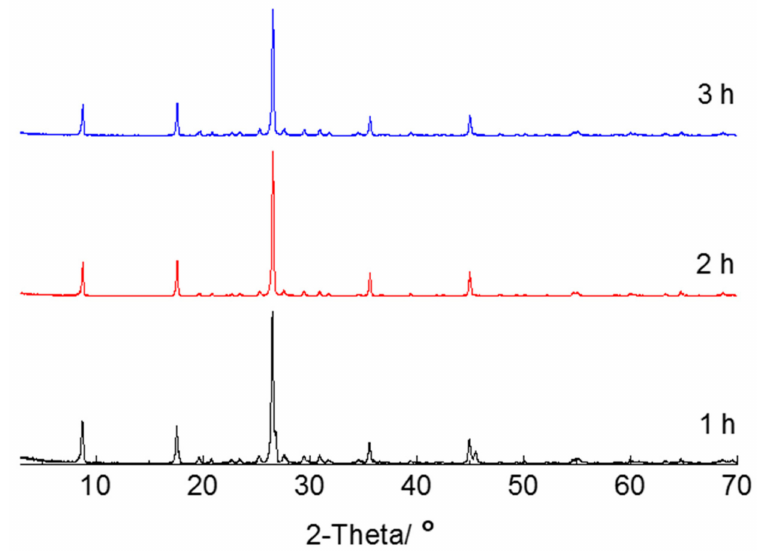
Figure 3. XRD patterns of sericite with different holding time at 800 ◦ C. Table 3. FWHM index for raw material and thermal-modified products in the (002) reflection.